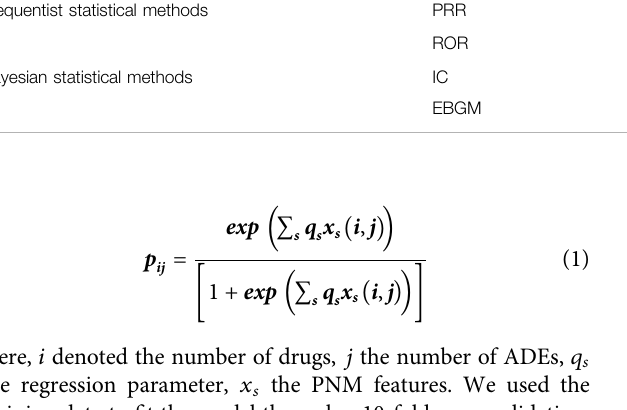
TABLE 1 | Association strength equation and threshold of signal detection algorithms. Frequentist statistical